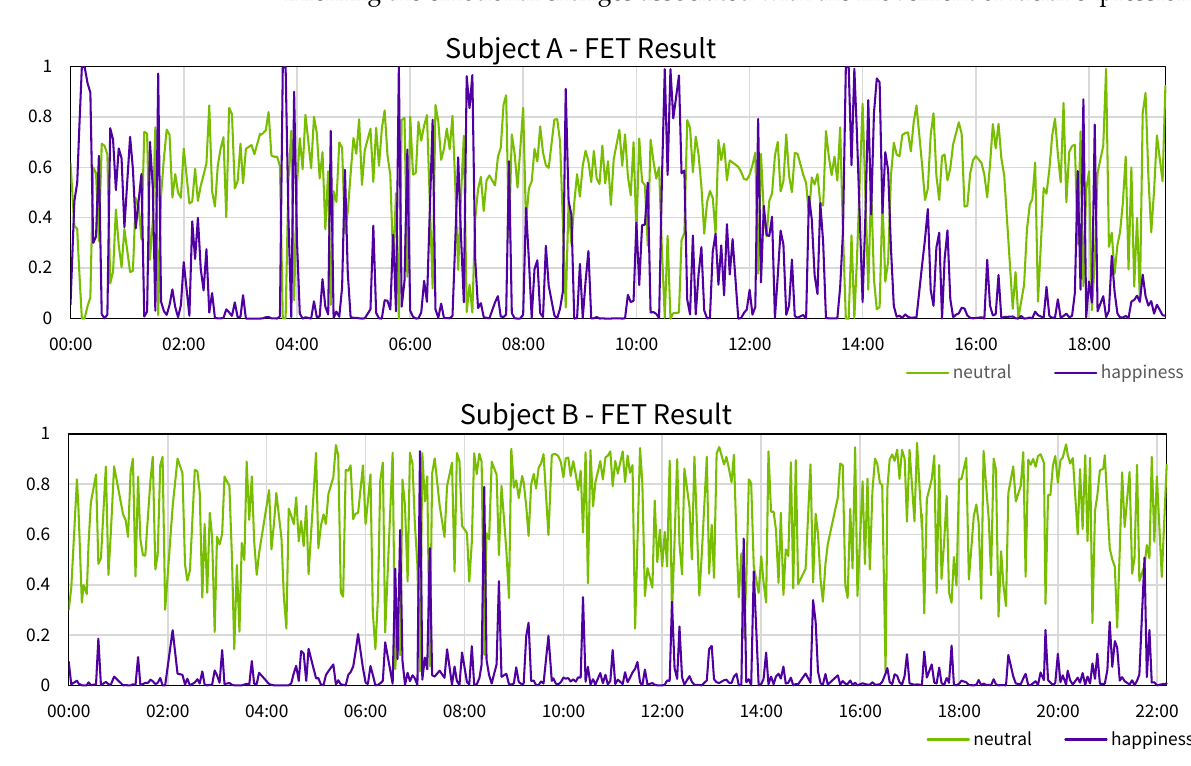
Figure 1. A part of the result of the FET